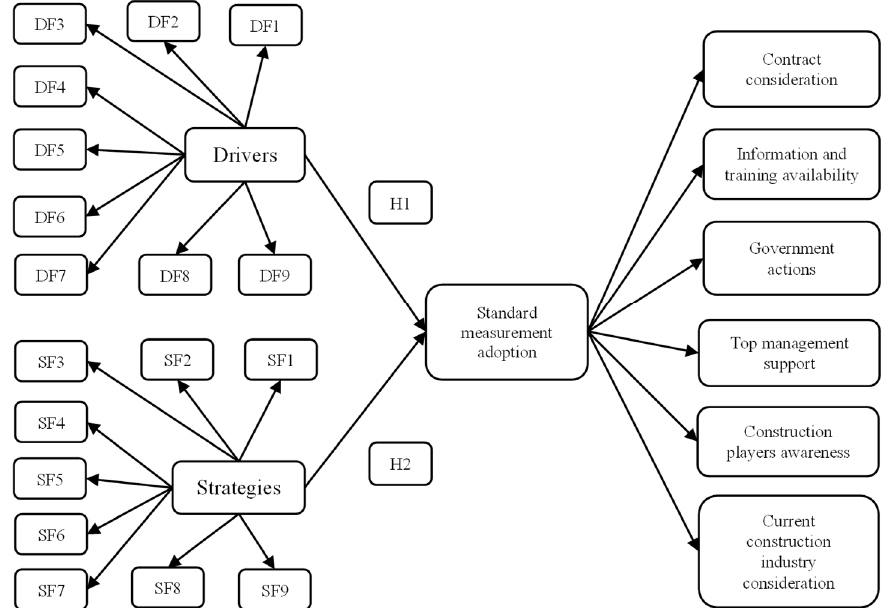
Figure 2. The hypotheses of the research. Note: DF—driver factor; SF—strategy factor. Hypothesis 1 (H1) . Driver factors (DF) have a significant effect on civil engineering standard measurement